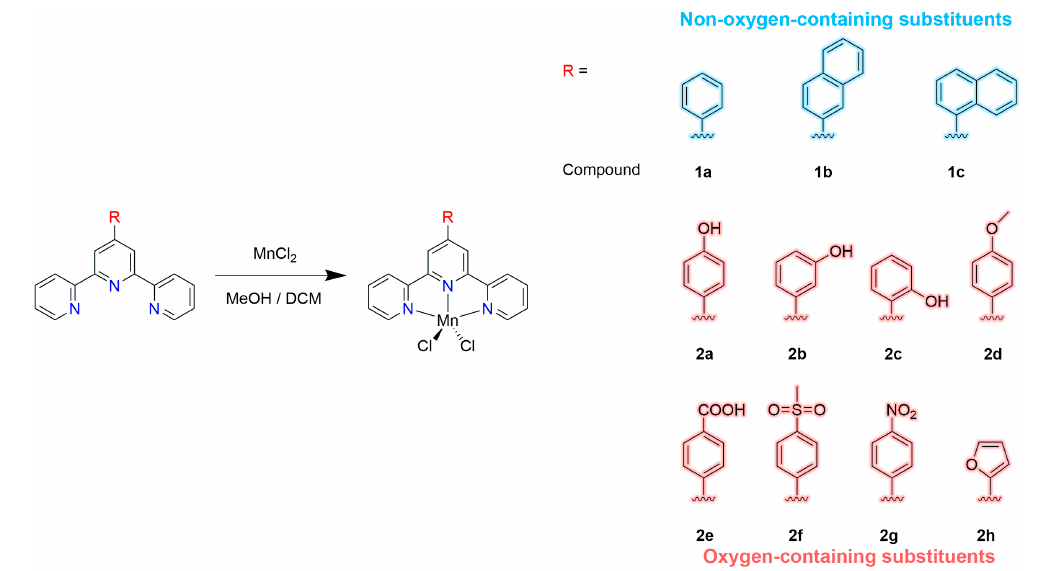
Figure 1. Synthesis of compounds 1a – 1c and 2a – 2h .